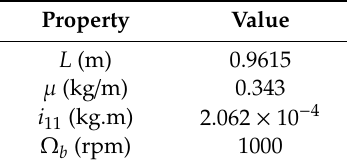
Table 3. The blade characteristics.